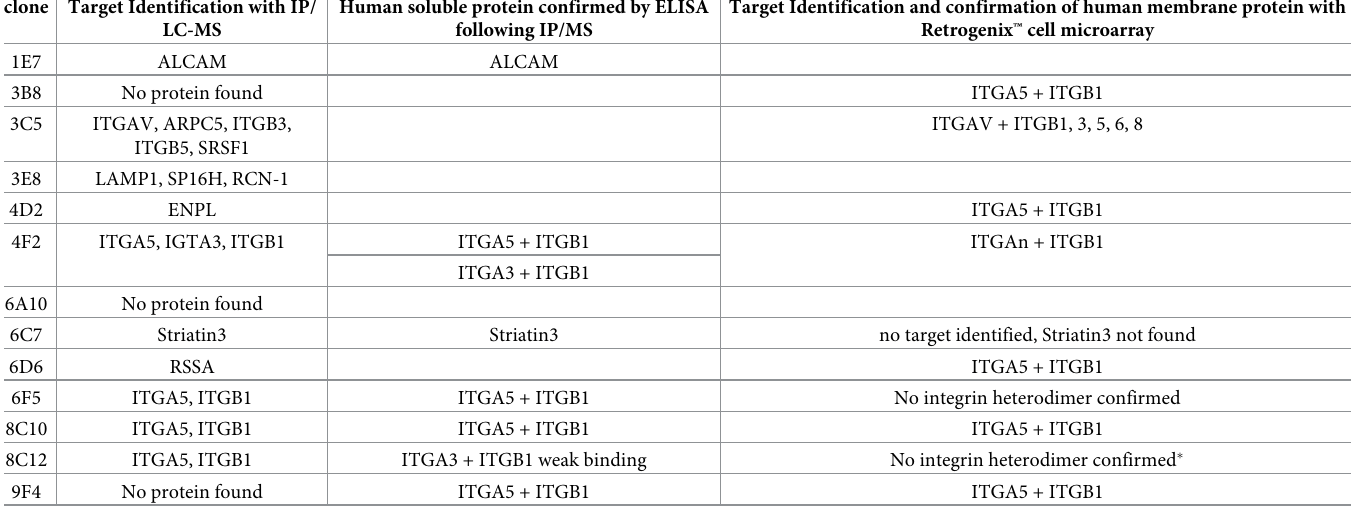
Table 2. Antibody target identification. clone Target Identification with IP/ Human soluble protein confirmed by ELISA LC-MS following